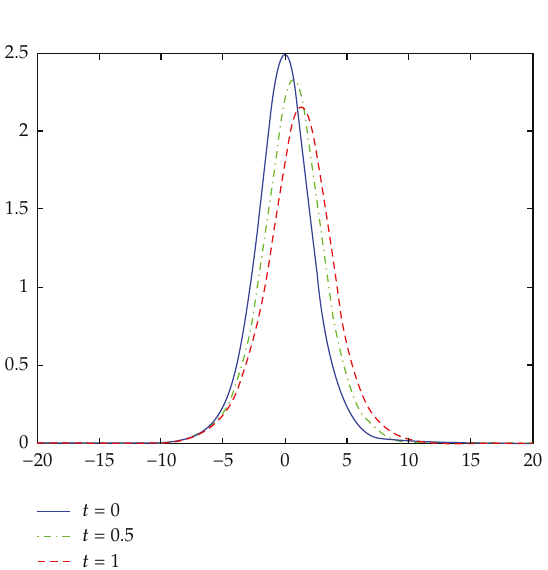
Figure 1: When τ (cid:7) h (cid:7) 0 . 05, the wave graph of u at various